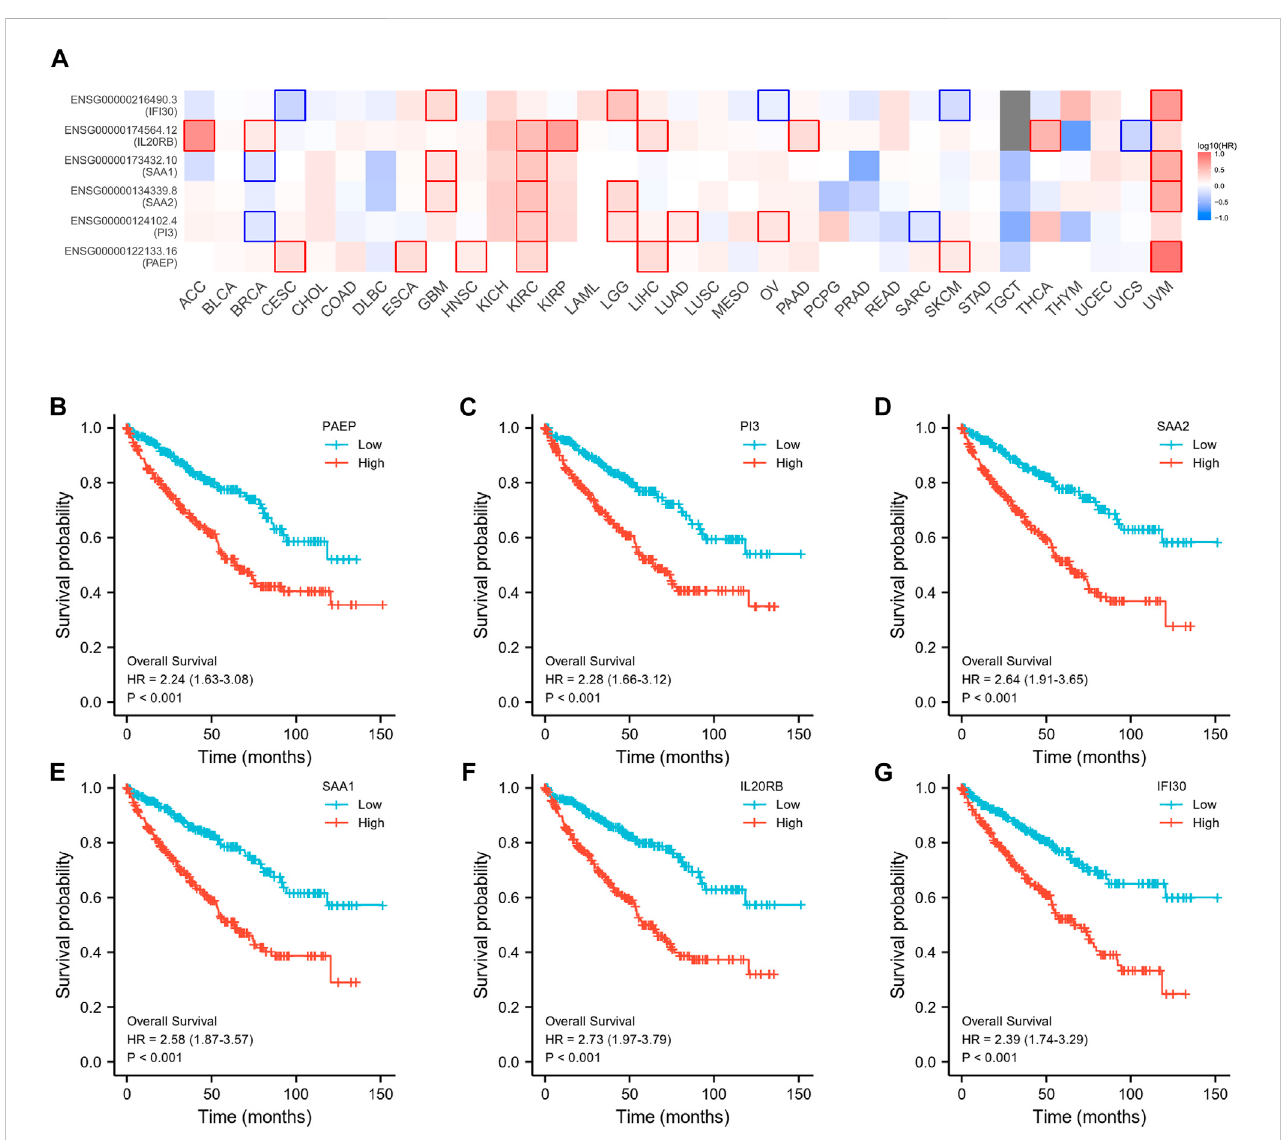
FIGURE 4 Prognostic analysis of six immunity-related genes in KIRC. (A) Establishment of an OS heatmap of these genes. (B – G) Survival analysis to investigate the association between the expression levels of PAEP, PI3, SAA2, SAA1, IL20RB, IFI30, and overall survival of